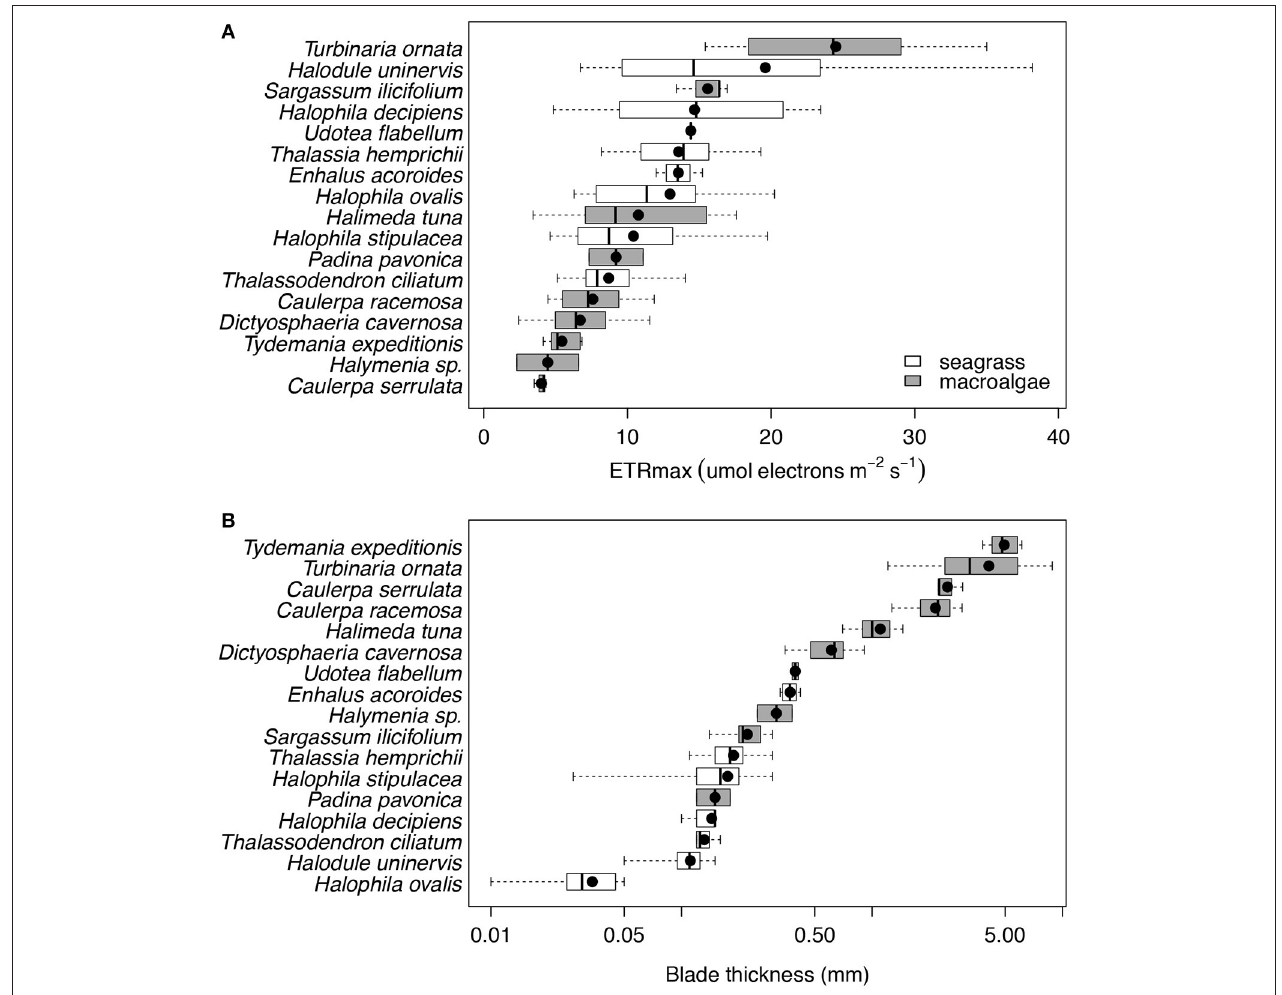
FIGURE 3 | Box plots of the ETRmax ( µ mol electrons m − 2 s − 1 ; ( A) and the blade thickness (mm; B ) for the 17 species of primary producers ordered by increasing mean values for the Red Sea, which are represented with black dots. Seagrass species are represented in white and macroalgae species in gray. The number of replicates is indicated in Table 2